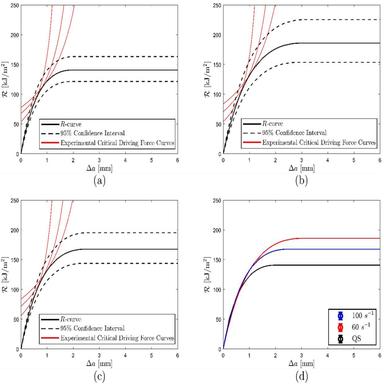
Size-independent mode I intralaminar R-curves: (a) quasi-static (QS); (b) 60 s − 1 (IR 1); (c) 100 s − 1 (IR 2); and (d) a comparison.